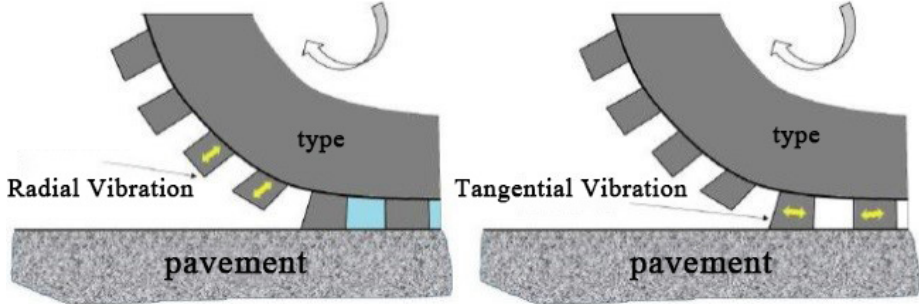
Figure 1. Tire vibration and noise.